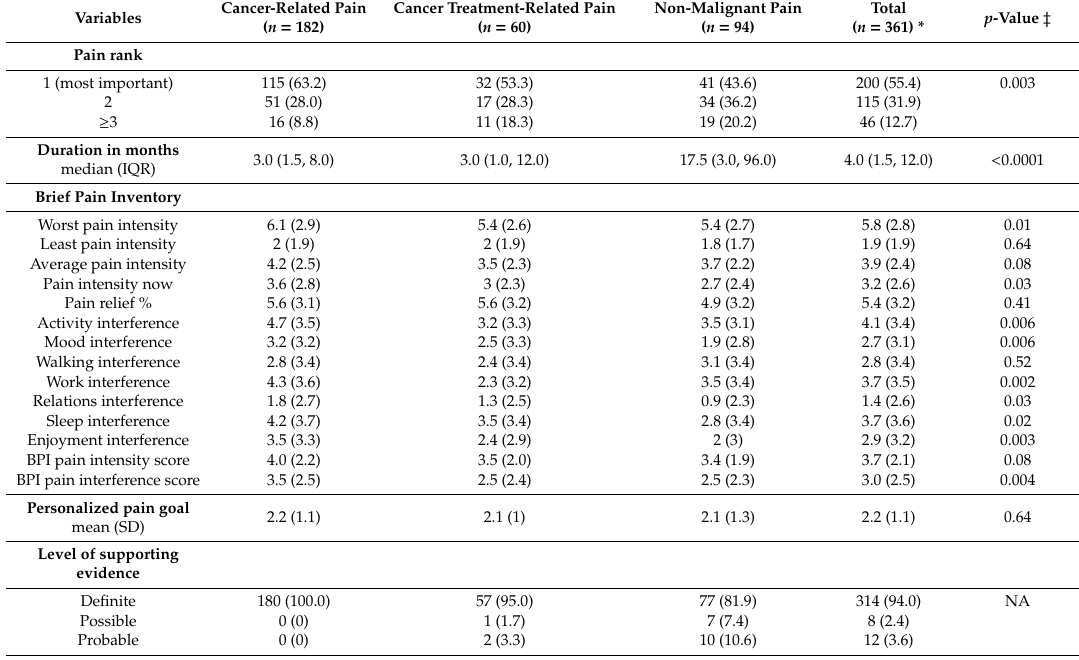
Table 2. Characteristics of pain diagnoses ( n =